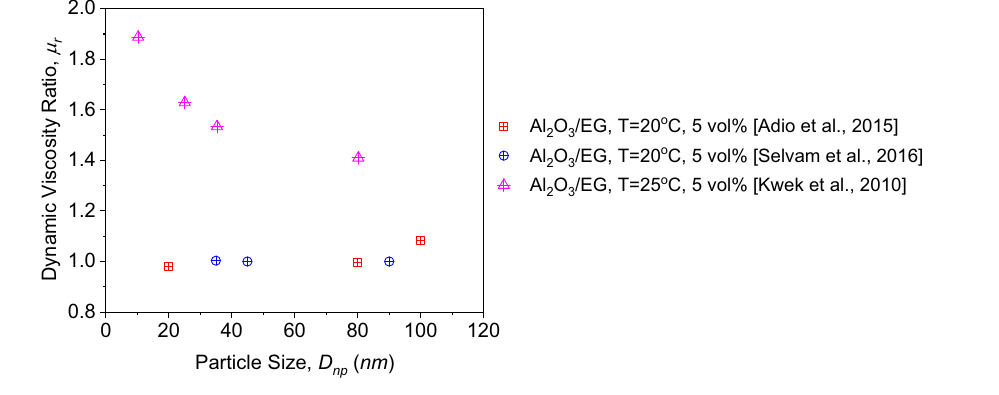
Figure 10: E ff ect of nanoparticle size in EG on dynamic viscosity ratio.